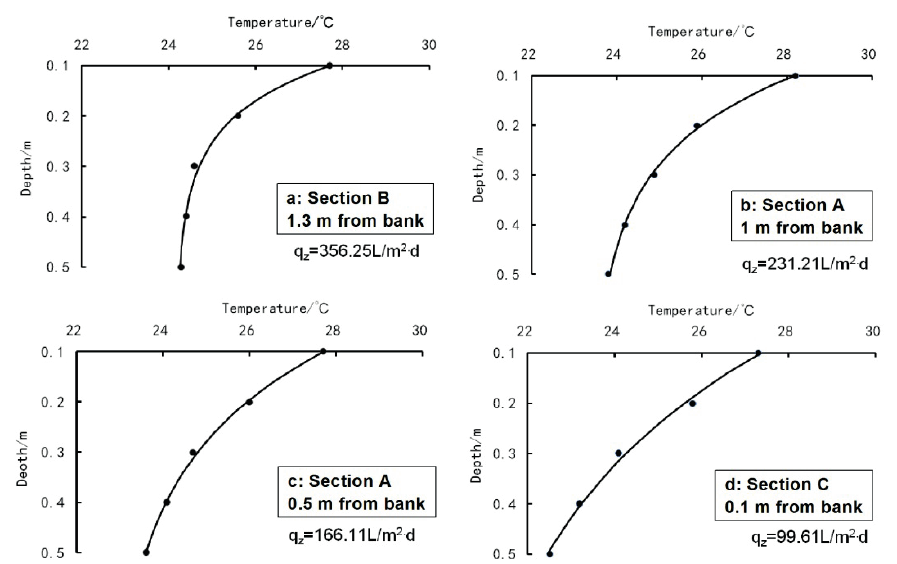
Fig. 4 Curve fitting of measured temperature at the test